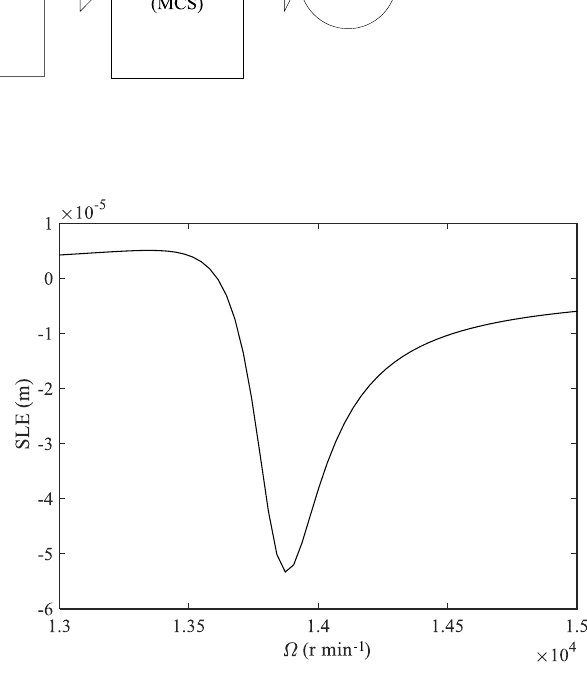
Figure 5. SLE in